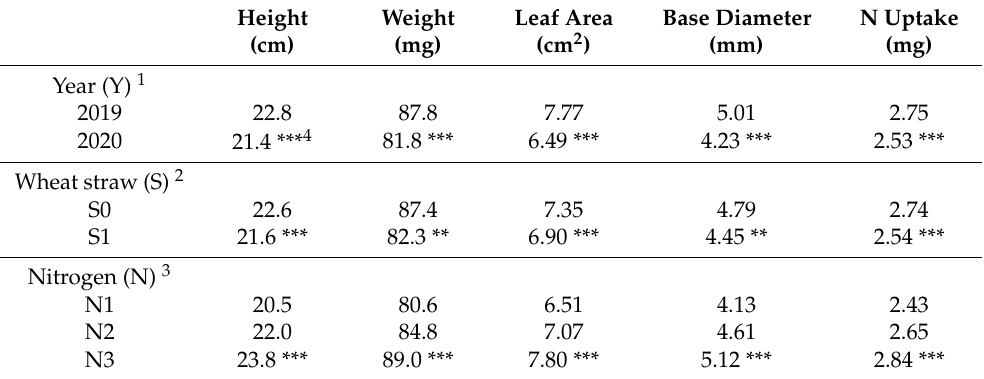
Table 4. Seedling morphological characteristics and N uptake at 35 days after sowing as affected by wheat straw returning (S0 or S1; n = 18), nitrogen (N1, N2, or N3; n = 12), and year (2019 or 2020; n = 18).